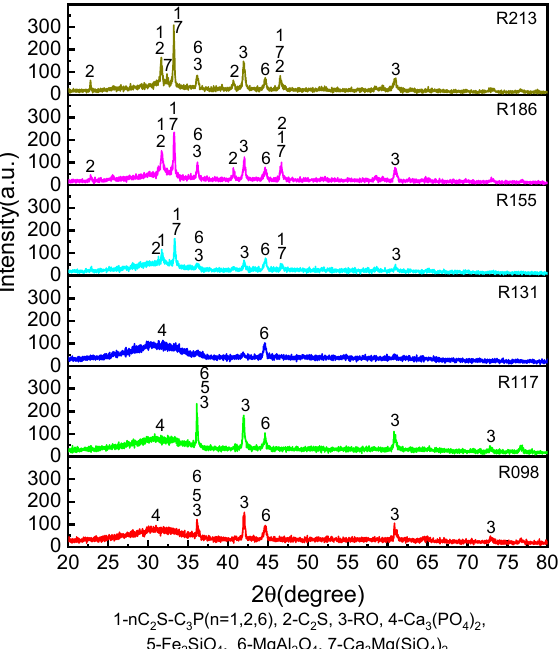
Figure 7. XRD patterns of the dephosphorization slag with different basicity.